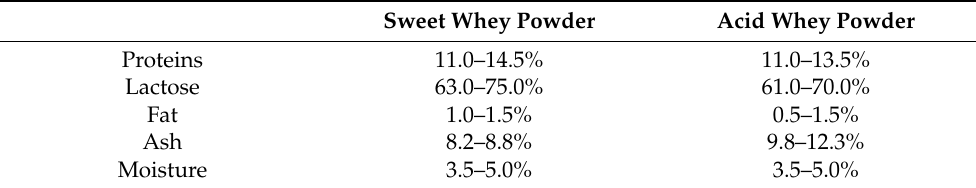
Table 2. Sweet and acid whey powders composition (adapted,